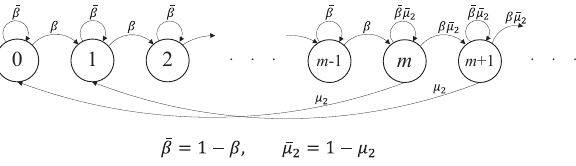
Figure 4. Markov chain model ˆ E t of the Type II node’s energy queue, given that the Type I node’s data queue ˆ Q t is in a steady state. Note that β = µ 1 P ( ˆ Q t ≥ 1 )